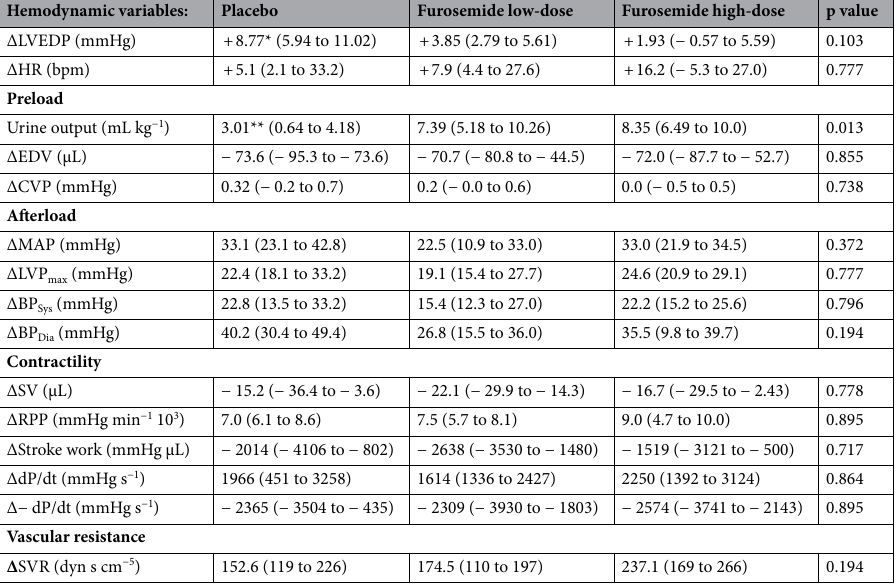
Table 2. Hemodynamic change pre vs. post-transfusion. Data presented as median (IQR) or mean ± SD. *Significant difference (p < 0.05) placebo vs. furosemide treatment (any dose). **Significant difference (p < 0.01) placebo vs. furosemide treatment (any